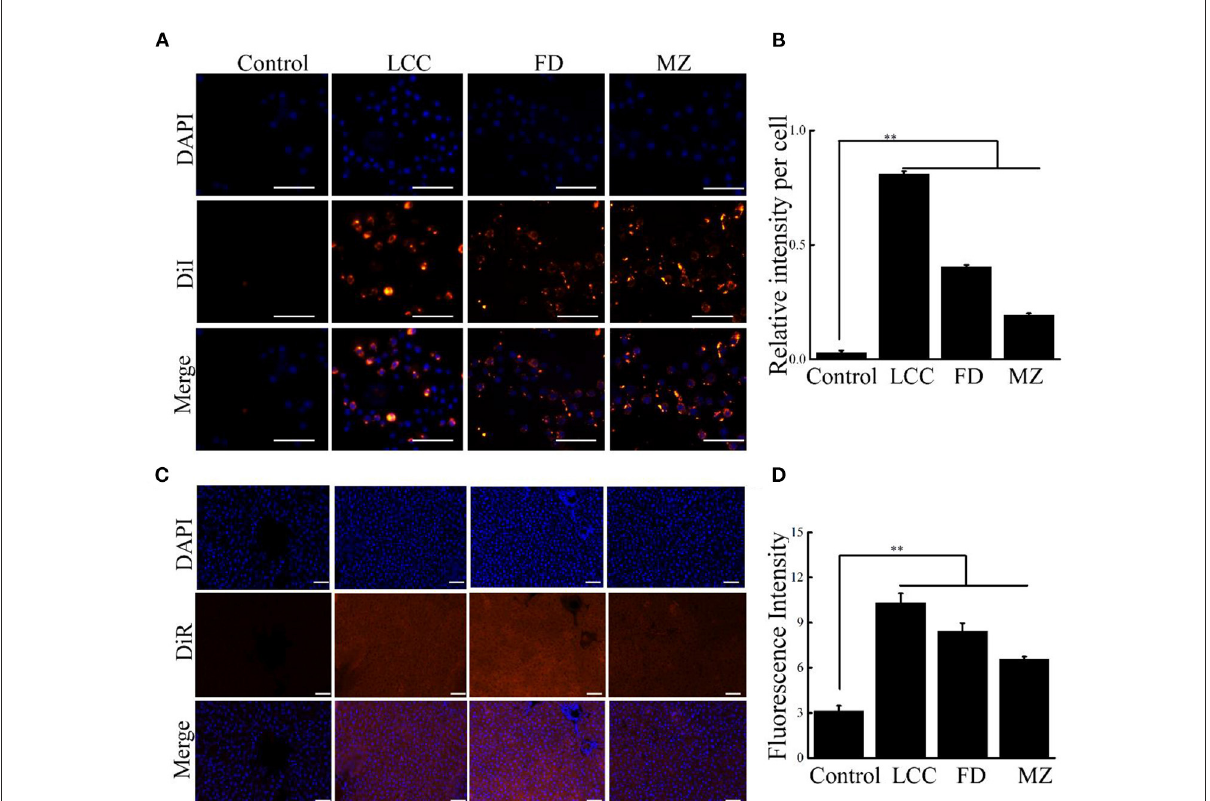
FIGURE2 Cellular uptake of TEVs into LX-2 cells and liver tissues. (A) Representative fluorescence microscope images of cellular uptake of TEVs at 10 µ g/mL. Scale bars = 20 µ m. (B) Quantification of the uptake of TEVs up to 24h. (C) Fluorescence images showing the accumulation of TEVs in healthy liver tissues after oral administration of DiR-loaded TEVs for 24h. Scale bars = 50 µ m. (D) Quantification of fluorescence intensities of the oral administration of DiR-loaded TEVs in mice. Error bar represents SD ( n = 3; * P < 0.05, ** P < 0.01, indicating significantly different from control